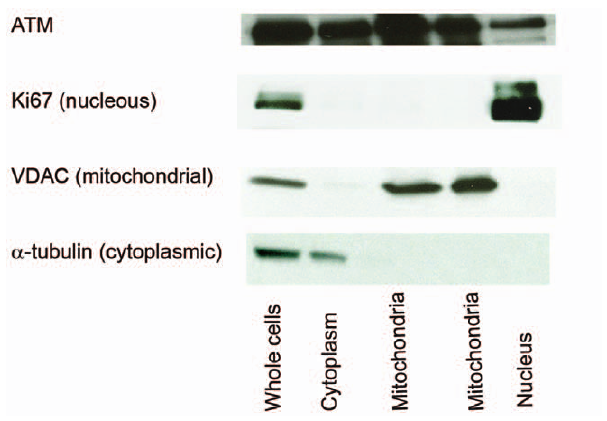
Figure 7. Subcellular localization of ATM. Total MCF-7 cell lysate and MCF-7 cells fractionated into cytoplasmic, nuclear and mitochon- drial extracts were immunoblotted with ATM antibody, a -Tubulin (cytoplasmic marker), Ki67 (nuclear marker) and VDAC (mitochondrial marker). The results indicate ATM immunoreactivity in mitochondrial extracts that are negative for cytoplasmic and nuclear